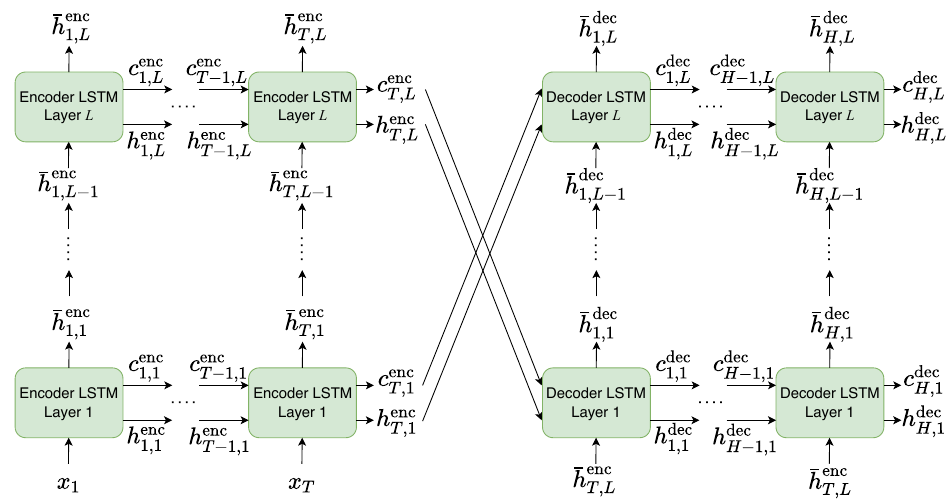
Figure 5. The neural architecture of the sub-network processing SCADA data, composed of an encoder ( left ) and a decoder ( right ).